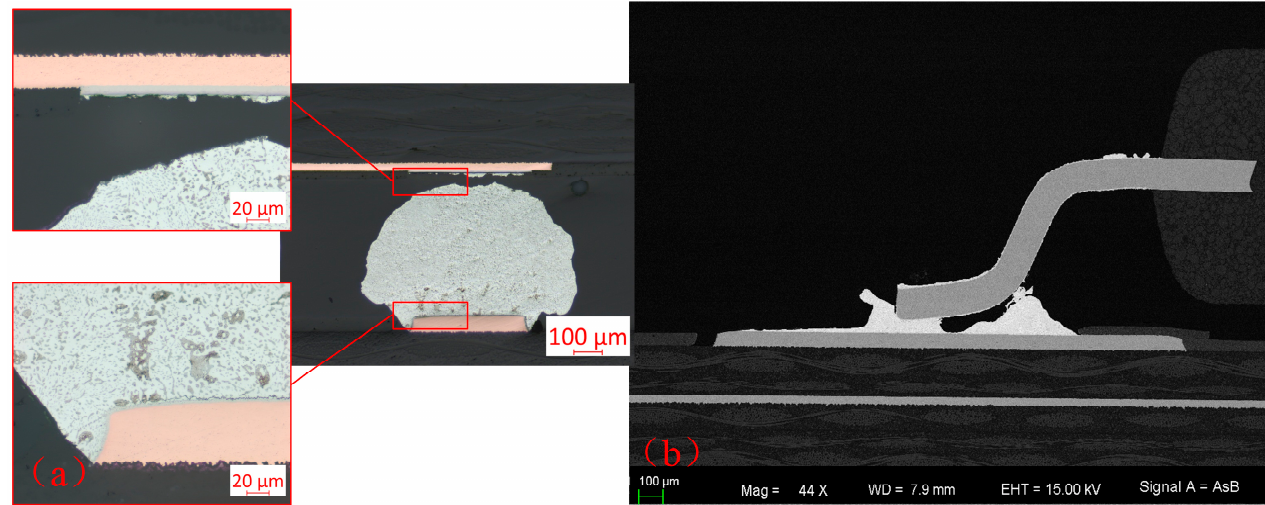
Figure 18. A SEM of failed component of the combined temperature cycling and random vibration tests: ( a ) a solder joint in D101; ( b ) a pin in D501.